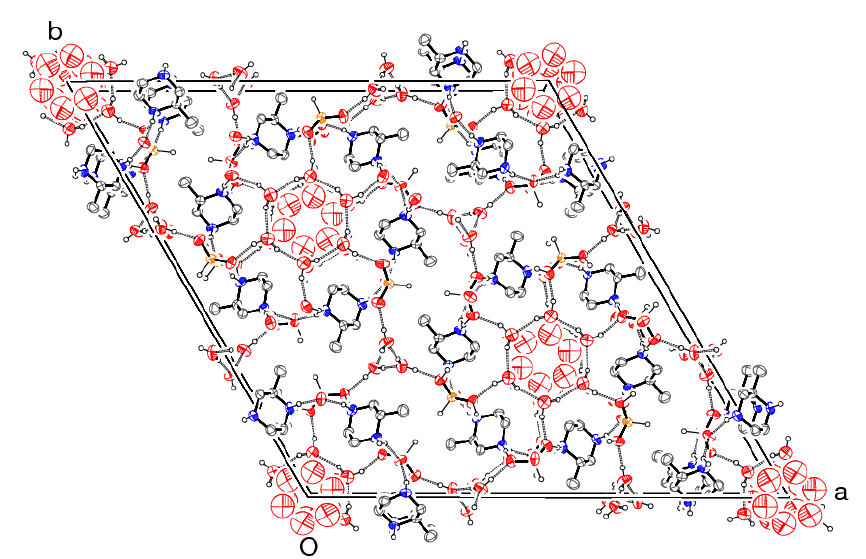
Figure 4. The unit-cell packing for 2 viewed approximately down the c axis direction. Hydrogen bonds are shown as double-dashed lines. The C-bound H atoms are omitted for clarity and all the orientations of the disordered O6 atoms are shown.